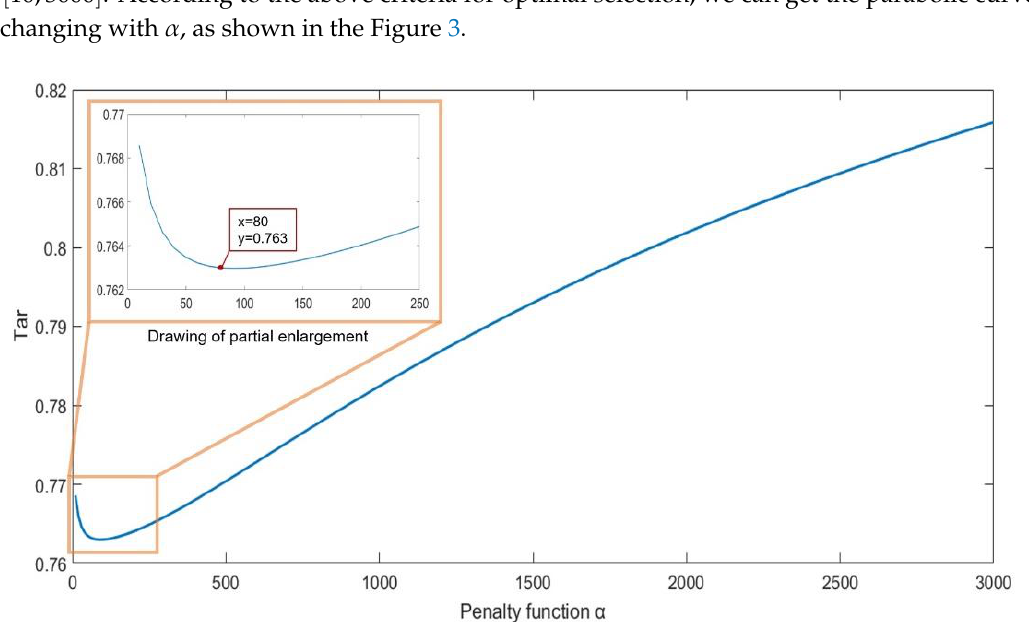
Figure 3. Optimal selection criteria curve.